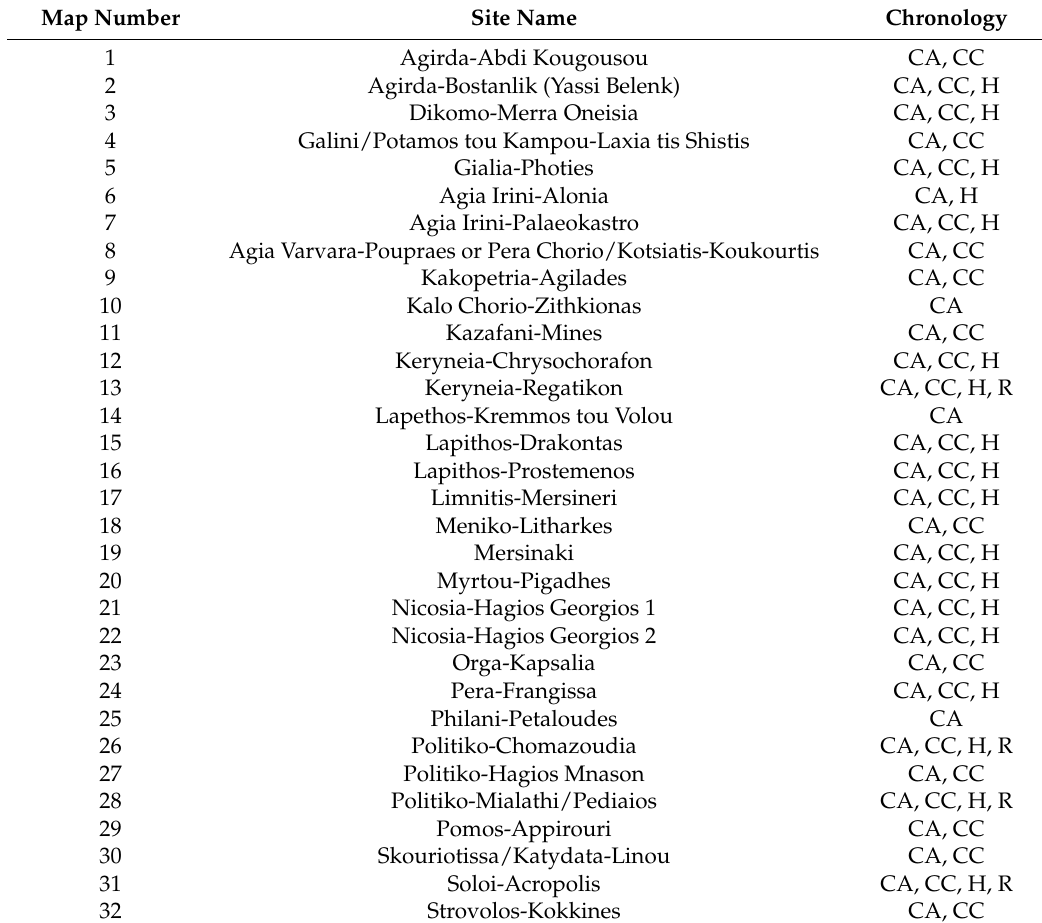
Table 2. Known Cypro-Archaic (CA), Cypro-Classical (CC), Hellenistic (H) and Roman (R) sanctuary sites included in the following GIS analyses and maps; Data derive from the Unlocking Sacred Landscapes of Cyprus (UnSaLa-CY)